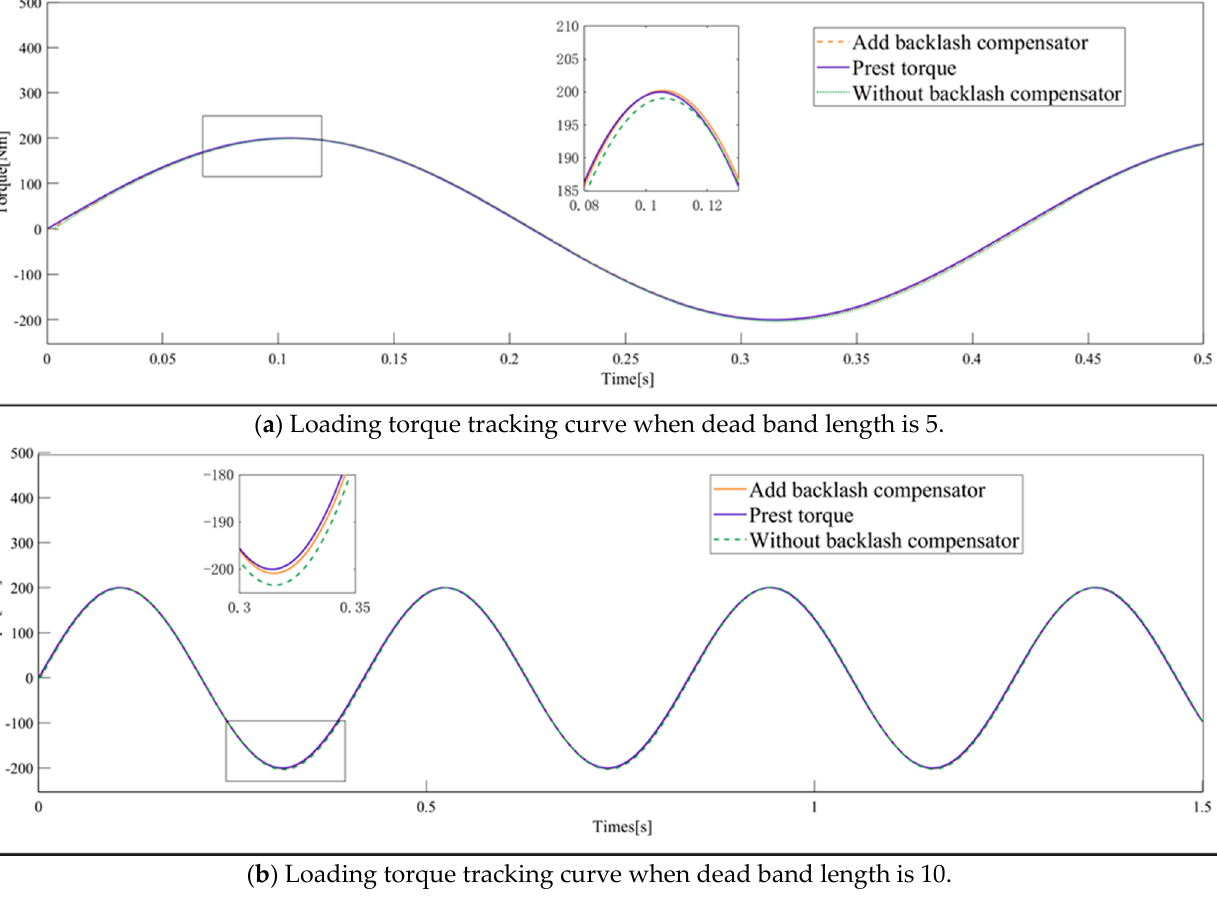
Figure 11. Loading torque tracking curve after adding backlash compensator and speed synchroniza- tion controller.